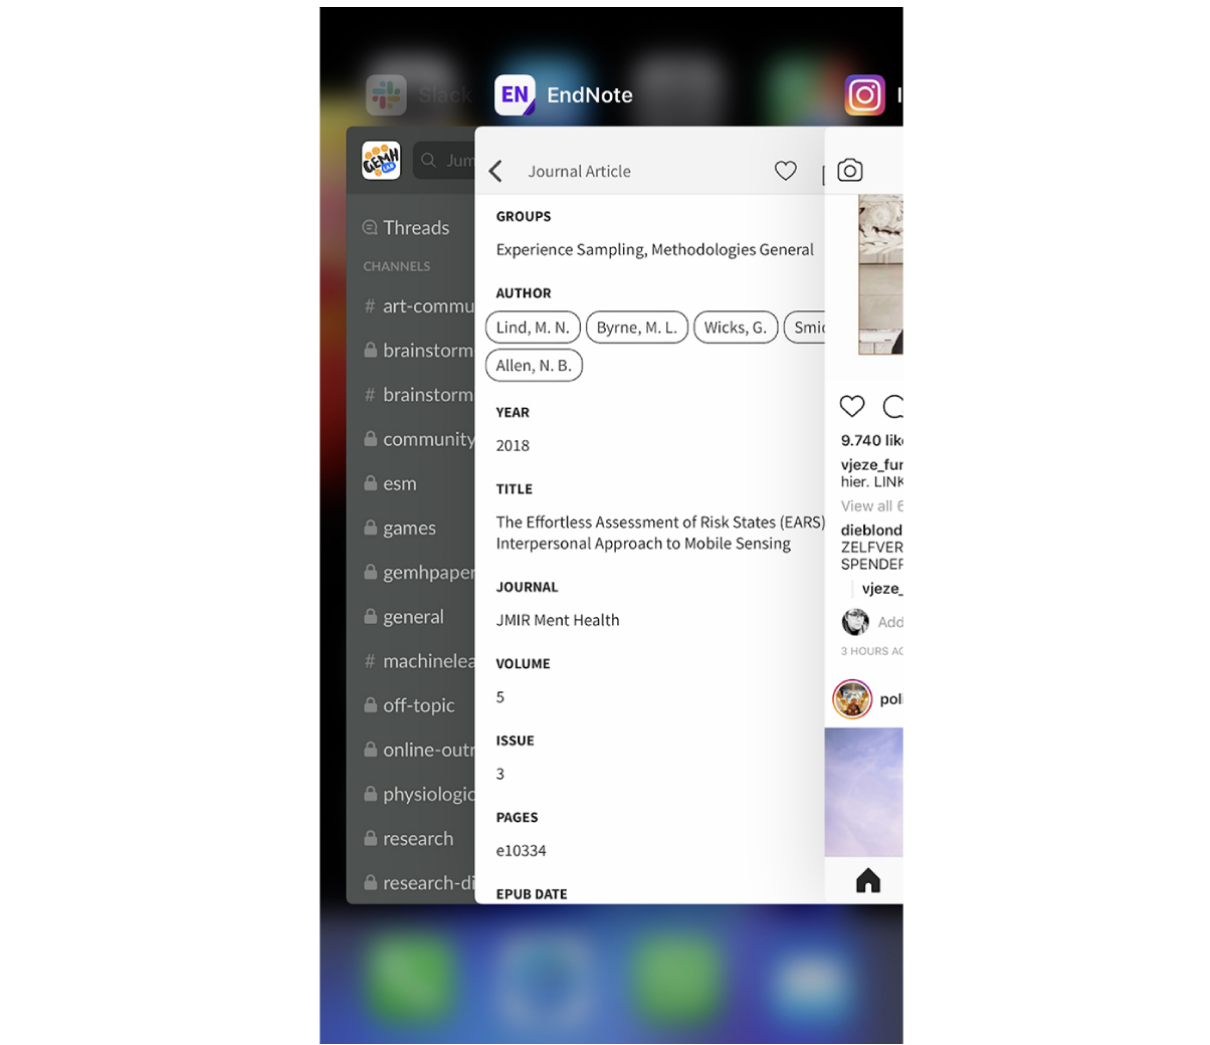
Figure 3. Screenshot of the opened apps overview on an